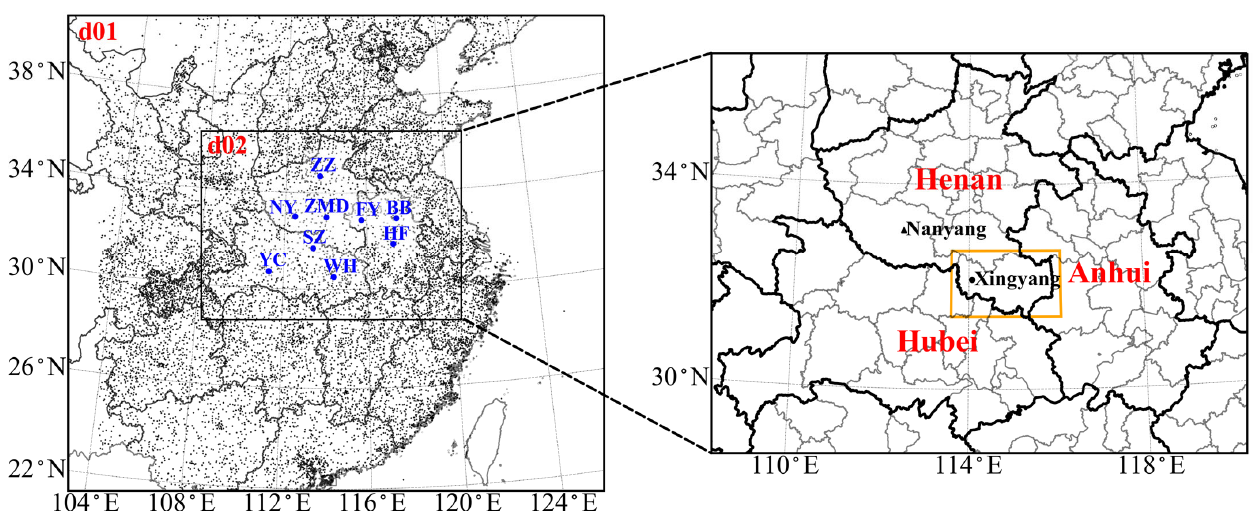
Figure 1. Model domain, distribution of radar and surface observation stations, the geographic information of the area of interest and other geographic conditions. The big blue spots represent the locations of the radar stations from Zhumadian (ZMD), Nanyang (NY), Suizhou (SZ), Fuyang (FY), Hefei (HF), Bengbu (BB), Zhengzhou (ZZ), Wuhan (WH), Yichang (YC). The small black spots represent the locations of surface data stations in the left panel. The orange box represents the area of interest, the black dot represents the location of Xinyang City, Henan Province, and the black triangle represents the location of the Nanyang Sounding Station in the right panel.